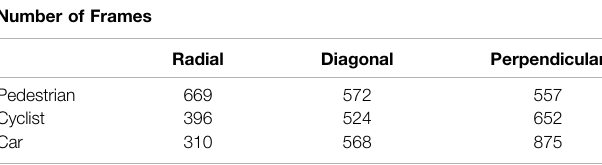
TABLE 4 | Number of frames captured for machine learning algorithms when different targets move in radial, diagonal, and perpendicular directions. Number of